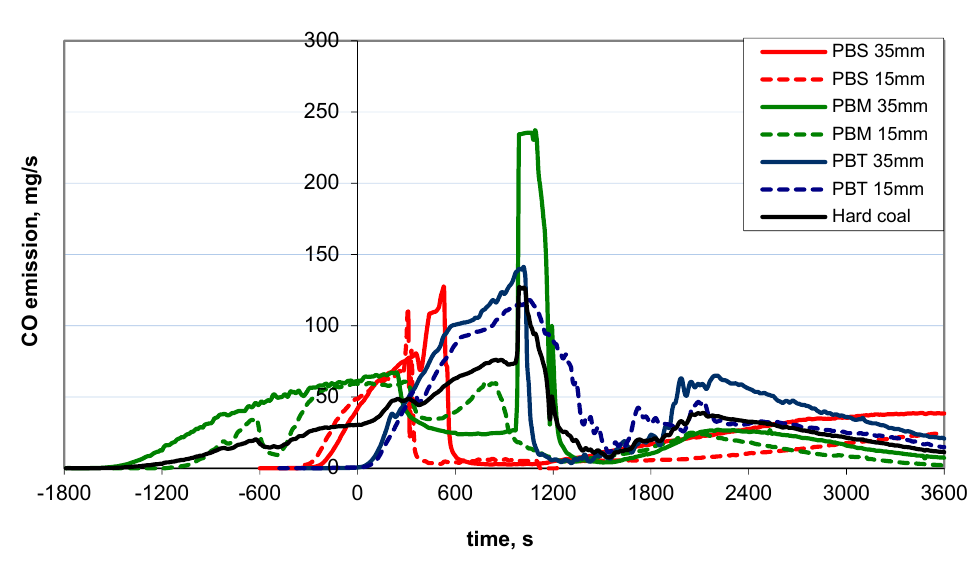
Figure 2. Variations of CO 2 emissions during combustion of fuels.